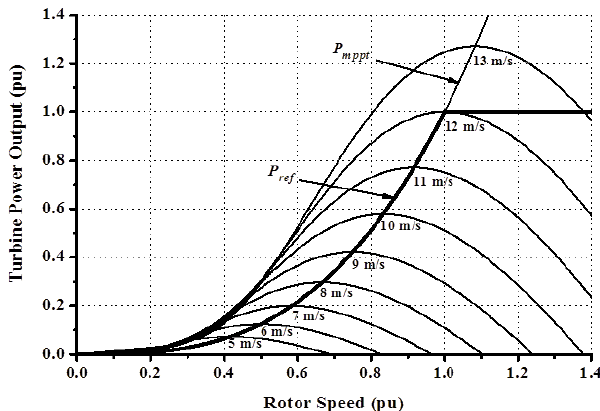
Figure 2. Turbine power output vs. rotor speed characteristic.